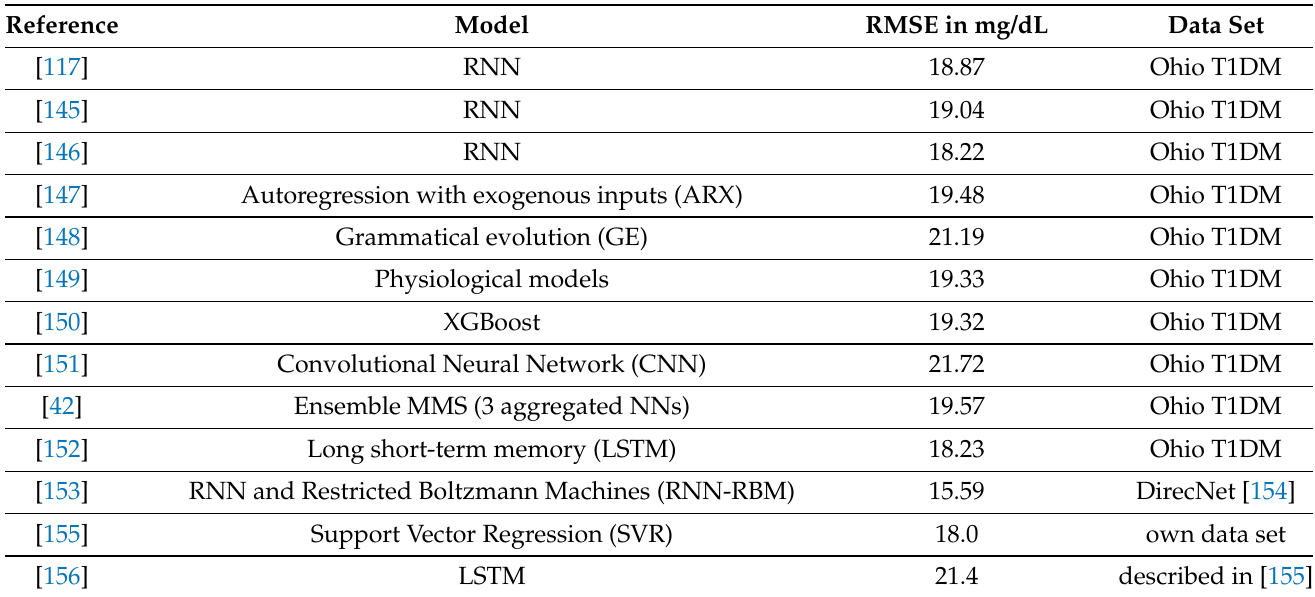
Table 11. Performance comparison for 30min prediction